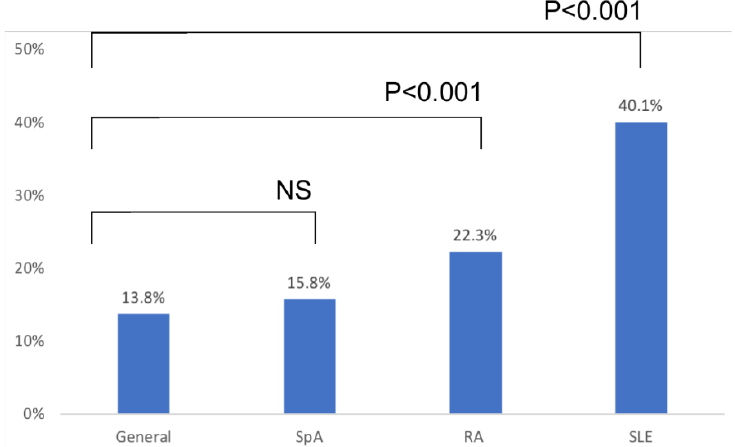
Figure 1. Prevalence of reported drug allergy among different rheumatological diseases.